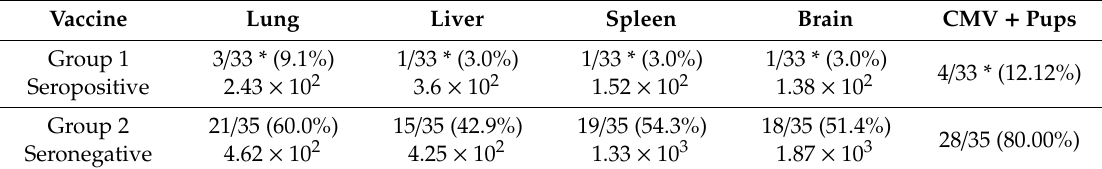
Table 3. Congenital infection outcome and mean viral load (genome copies / mg tissue) based on cytomegalovirus (CMV) detection in target tissues of